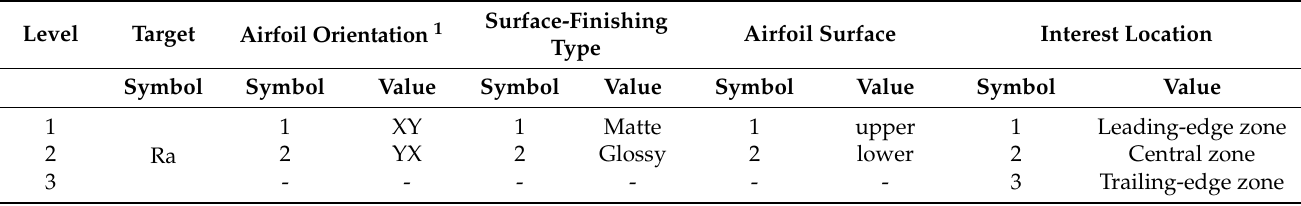
Table 1. Control factors and their